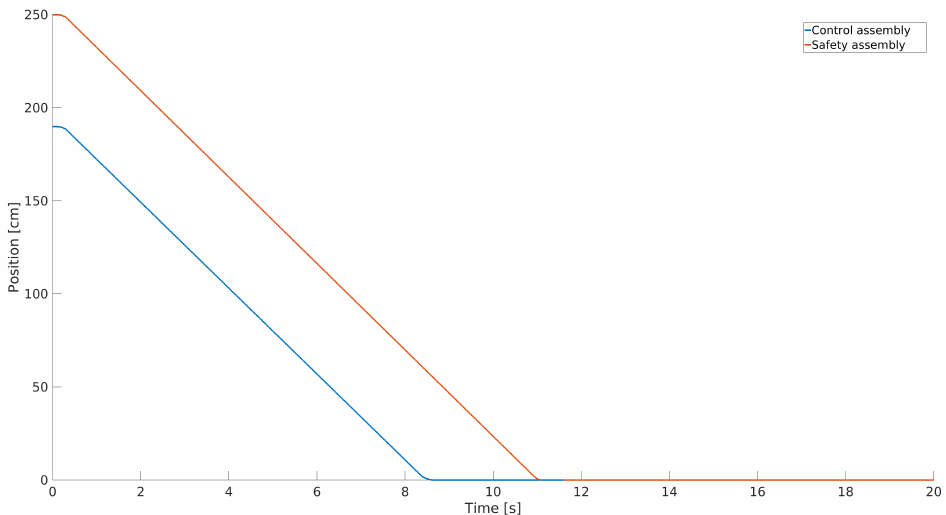
Figure 5. Averaged assembly positions in